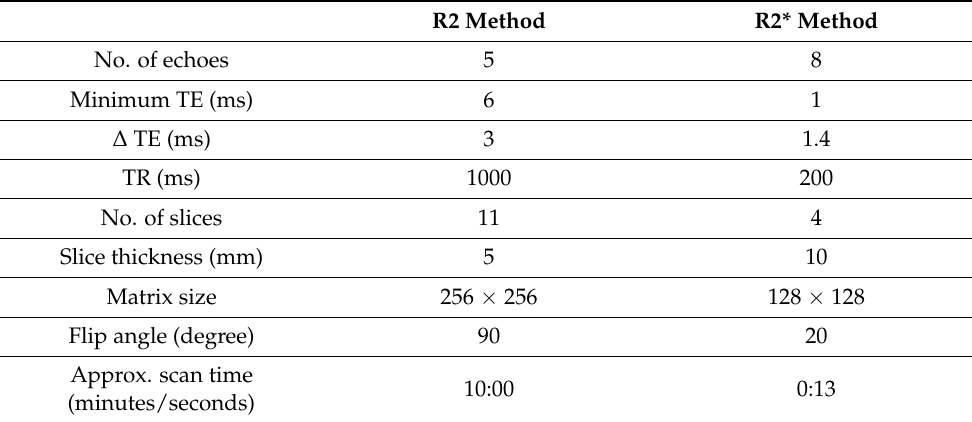
Table 1. Acquisition of R2 and R2* sequence